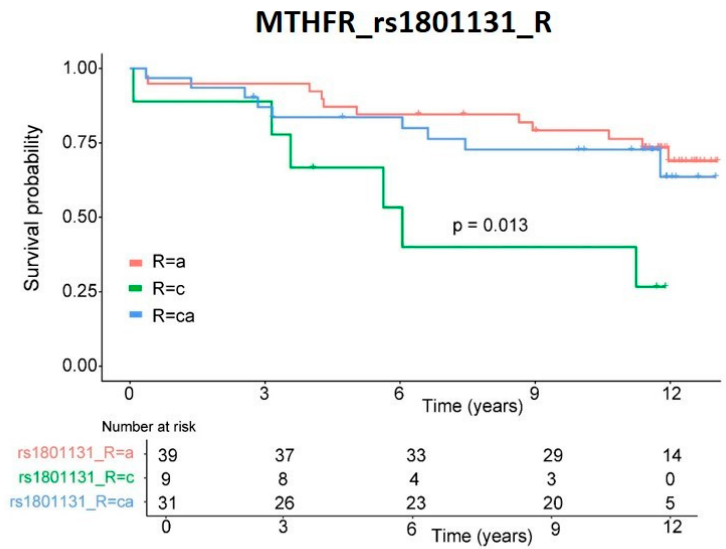
Table 4. Pharmacogene variants significantly associated with tumor incidence after FDR calculation employing the p -values of selected variables in cancer risk and exitus studies by logistic and Cox regression. Figure 2. Survival rate. Kaplan–Meier representation of patients’ survival rates depending on ge- netic variants in recipient MTHFR rs1801133 SNP. Significance was obtained by log-rank analysis.